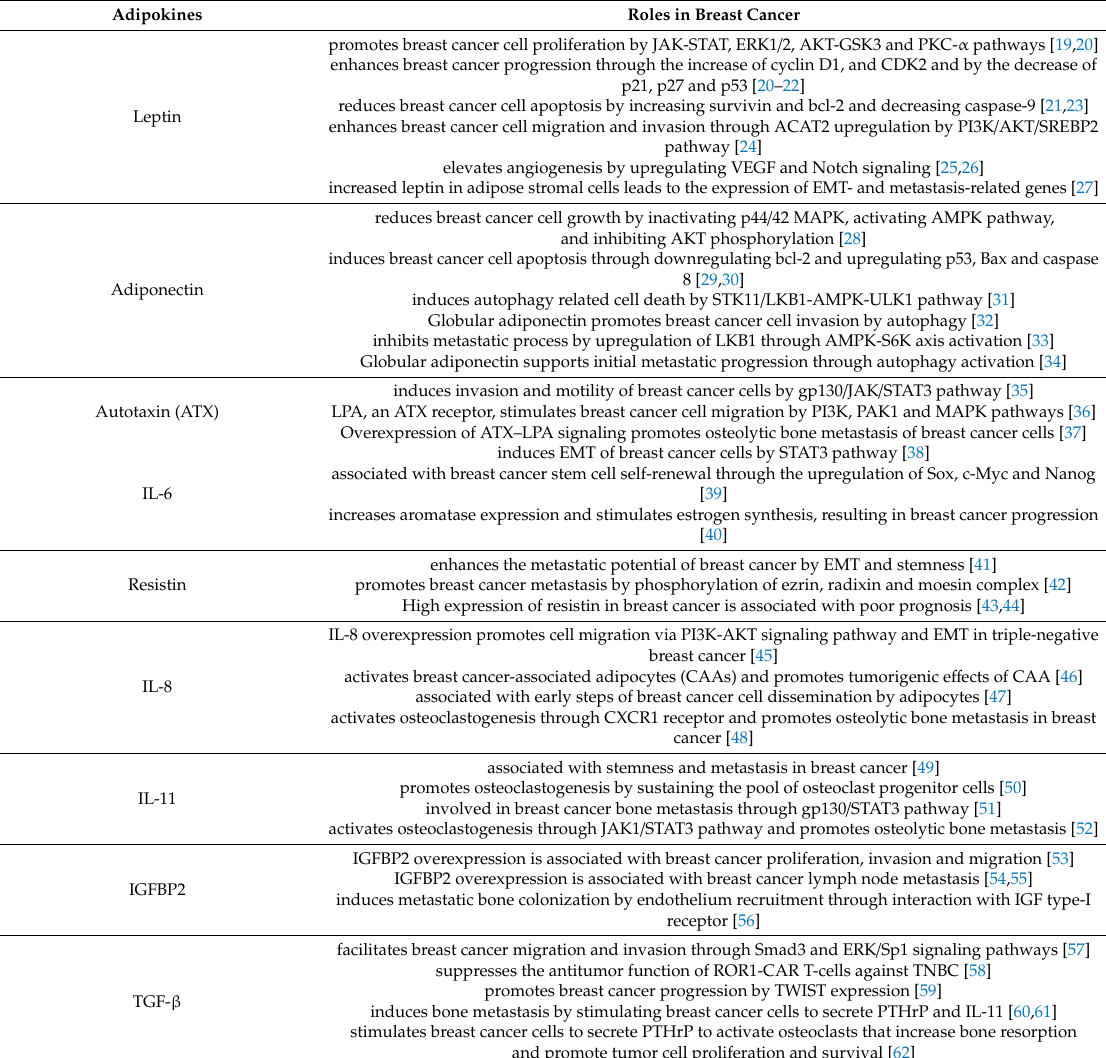
Table 1. Summary of the roles of adipokines in breast cancer